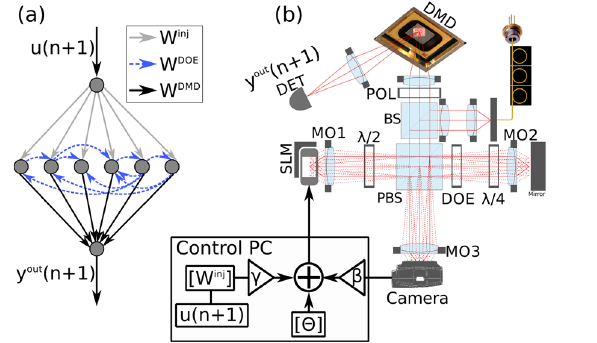
Figure 1: (a) Schematic illustration of a recurrent neural network. (b) Photonic implementation of a spatio-temporal neural network with 961 nodes. An optical plane wave illuminates the spatial light modulator (SLM), the neural network states are encoded by the SLM pixels. These are imaged on the camera, passing through a polarizing beam splitter (PBS) and the diffractive optical element (DOE) creating the coupling between network states. The information detected by the camera is used to drive the SLM. The network ’ s output weights are realized via a digital micro-mirrors device (DMD) which creates Boolean readout weight matrix W DMD